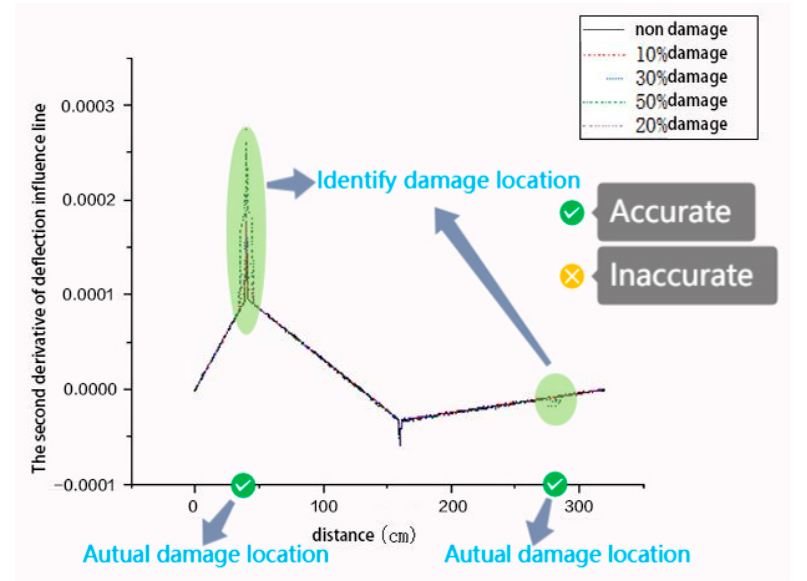
Figure 13. The 2nd derivative of deflection influence line at 1/4 determining point of the 1st span under work condition 1 (2-5).